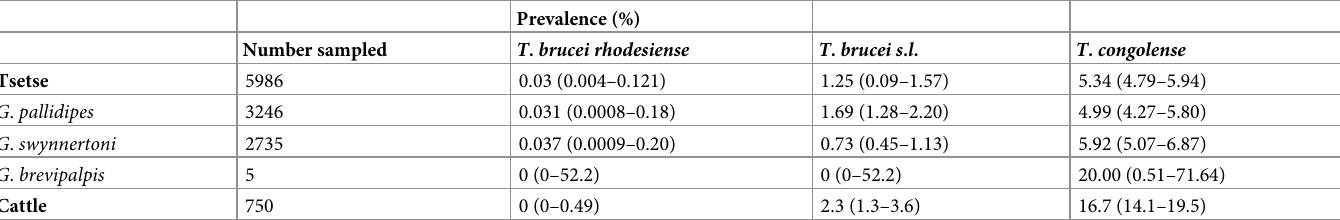
Table 3. Prevalence of trypanosome species in tsetse and cattle. Prevalence defined as the percentage of hosts or vectors testing positive for the presence of DNA for the respective species: 95% confidence intervals in parentheses. Prevalence